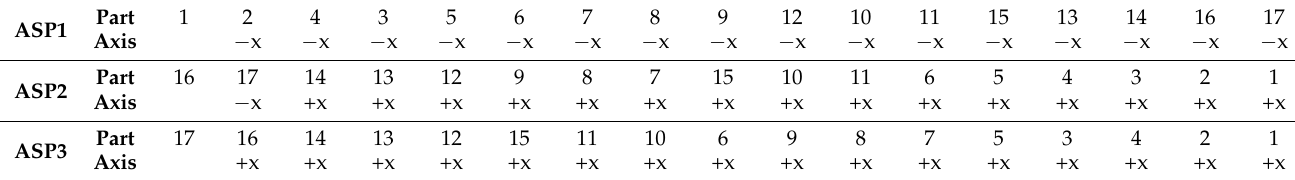
Table 3. Three possible assembly sequence plans of the speed